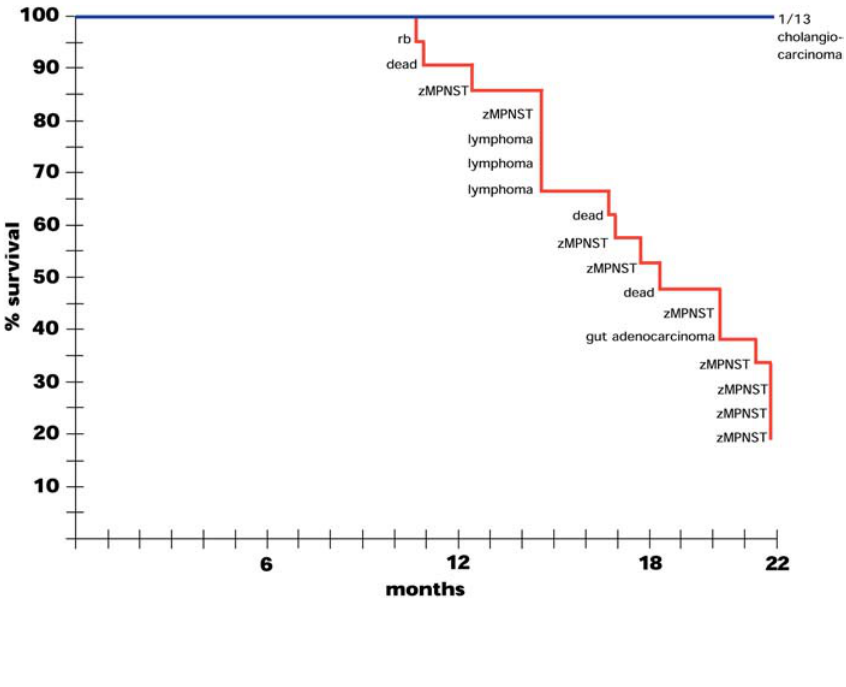
Table 2. Onset of Tumor Development in hi10 Fish and Noncarrier